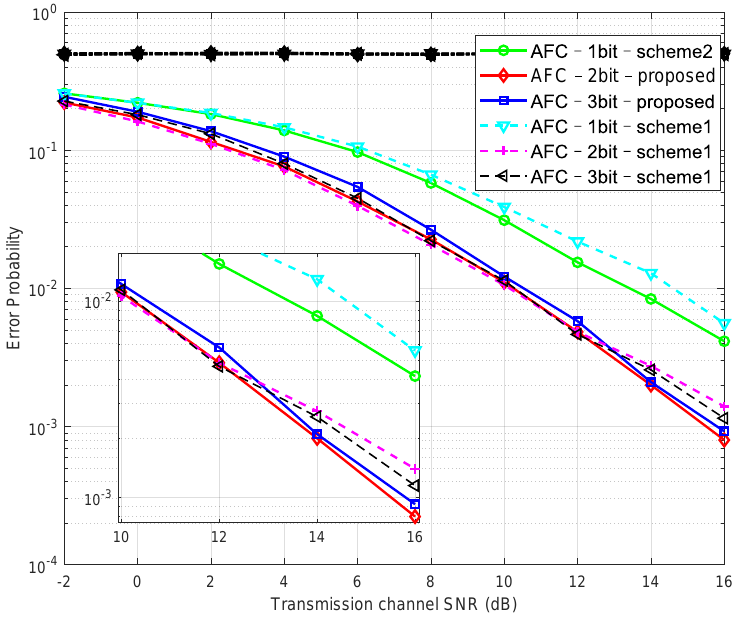
Figure 4. Error probabilities of the soft data fusion varying with the SNR of transmission channel for β = 0.8 and snr L = 5